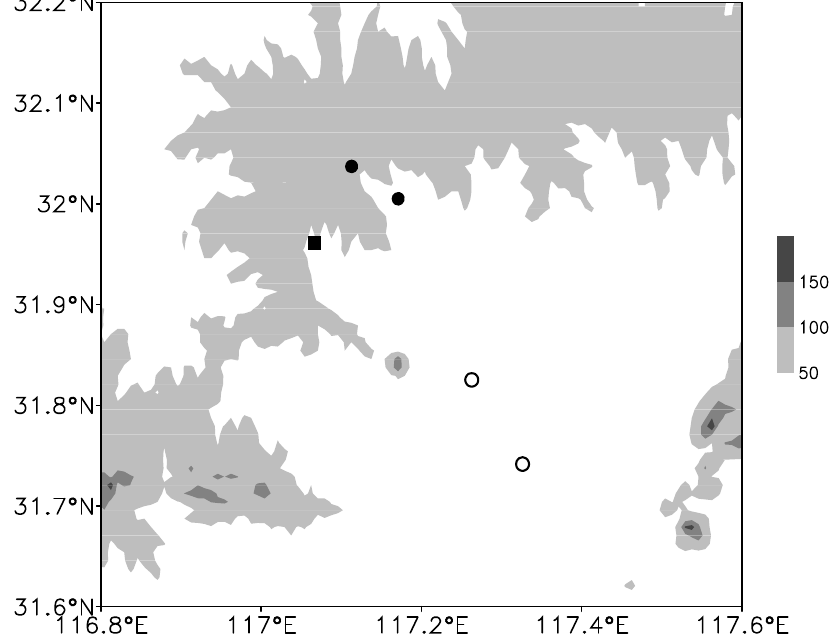
Figure 1. The spatial distribution of meteorological stations and the surrounding topography. ( ■ : subsurface temperature observational site; ● : road surface station; ○ : bridge deck station; shaded area indicates topography, unit: m).